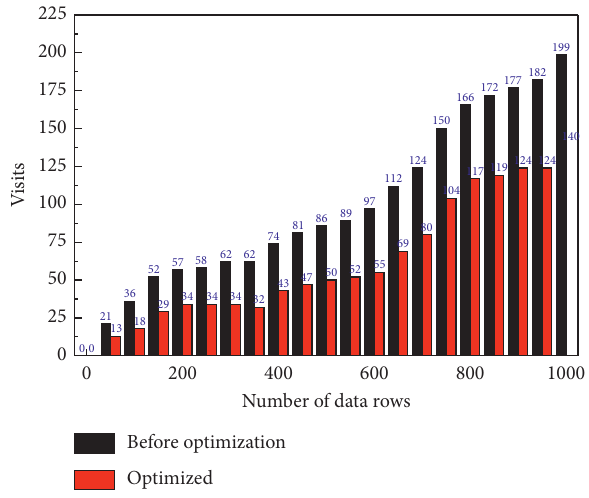
Figure 7: Number of data accesses for detection tasks based on the objective